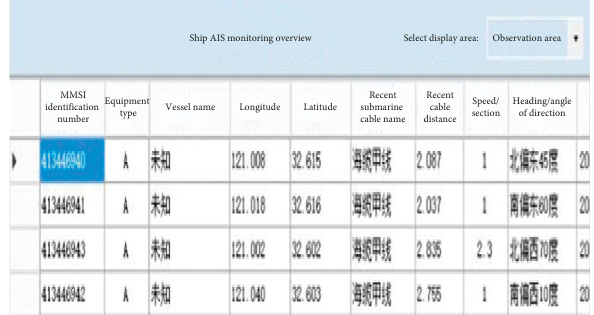
Figure 14: Ship information bar interface.